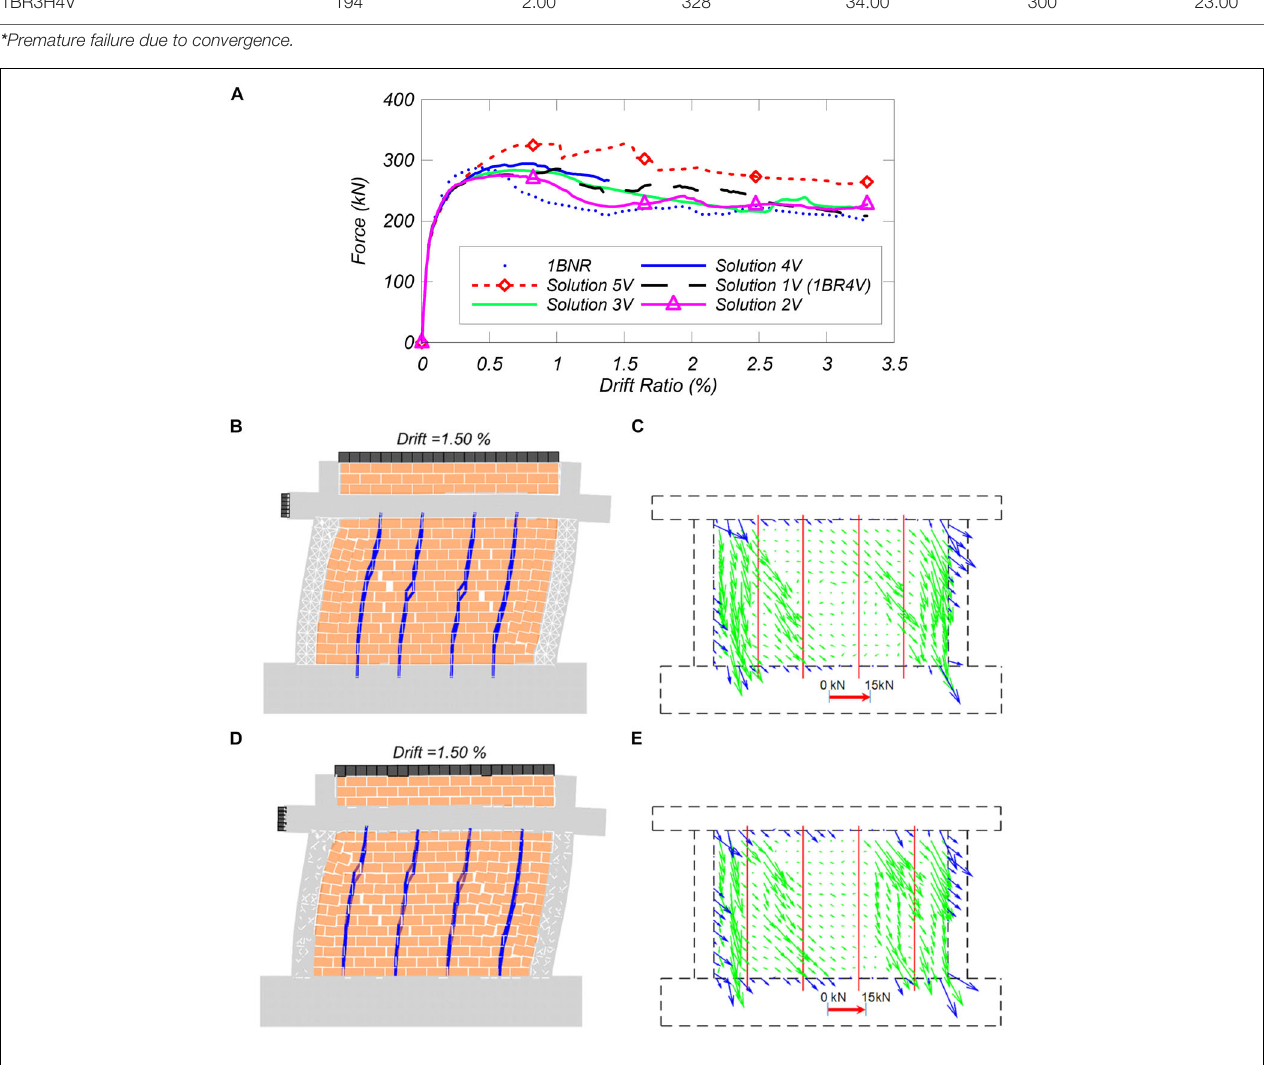
FIGURE 12 | Response of one-bay frame retrofitted with different number of vertical NSM bars: (A) lateral force vs. drift ratio of the models with different retrofit solutions using vertical NSM bars, (B) deformed shape of Solution 2V, (C) force distribution of Solution 2V, (D) deformed shape of 1BR4V, and (E) force distribution